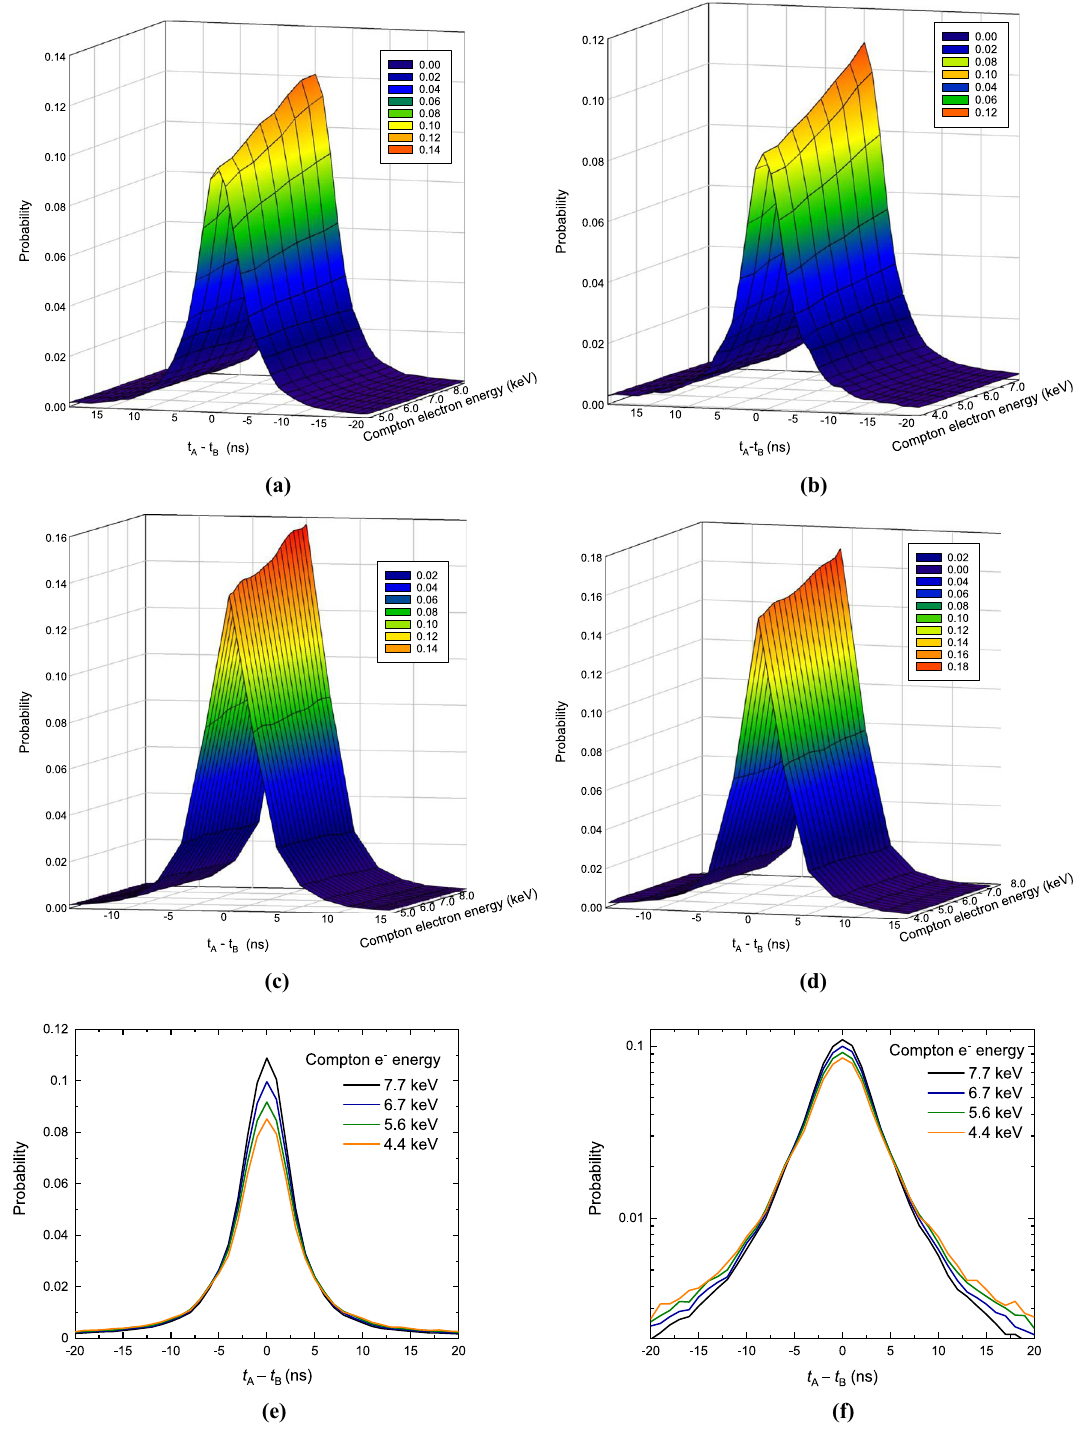
Figure 2. Cross-correlation spectra D (� t ) of different LS cocktails acquired by the Compton coincidences method: ( a ) Ultima Gold; ( b ) Ultima Gold LLT; ( c ) Hionic Fluor; ( d ) Toluene, PPO, POPOP locally made cocktail; cross-correlation distribution for several deposited energies measured in Ultima Gold LLT liquid scintillation cocktail in linear ( e ) and log-scale ( f